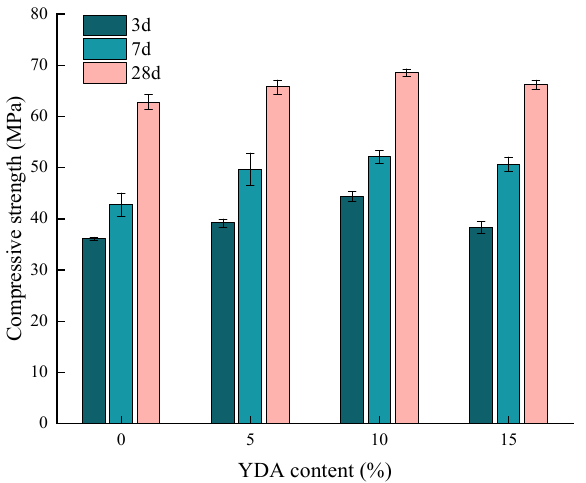
Figure 8. Effects of YDA content on the compressive strength of cementitious mortars.